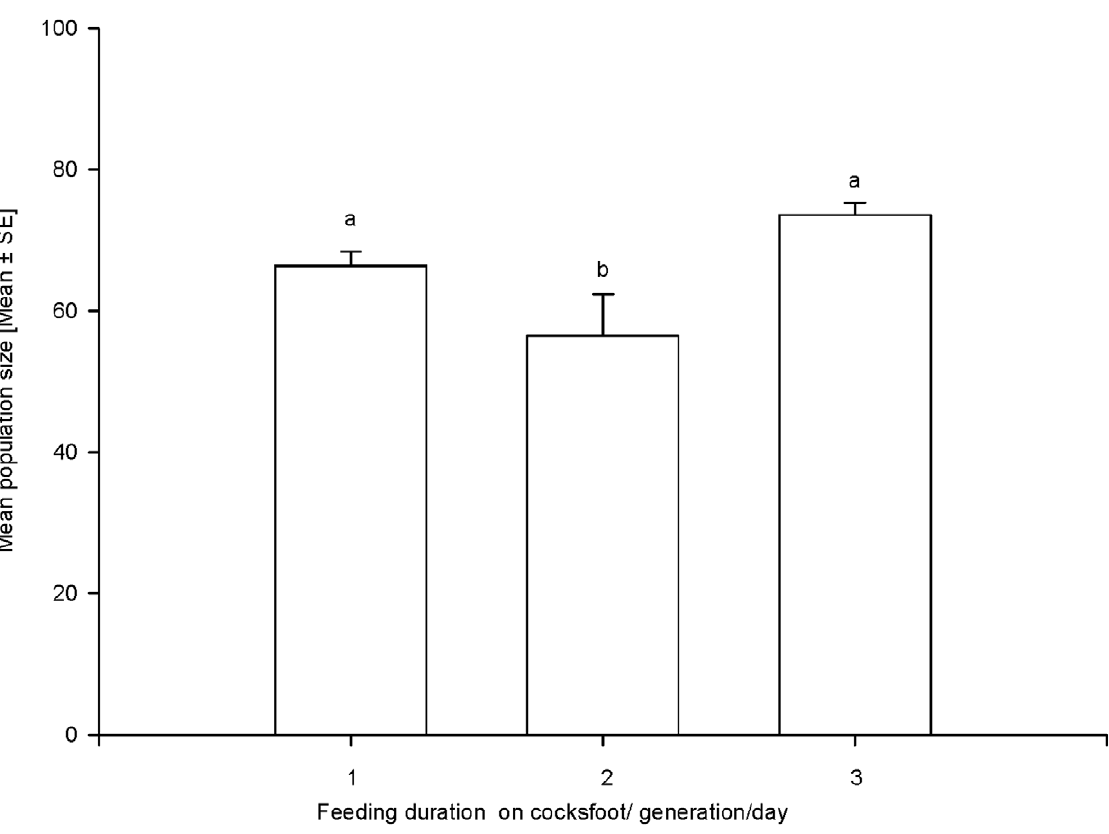
Figure 5. Effect of feeding duration on cocksfoot on the performance of S.avenae clone 5 on wheat; aphids fed many times with varying duration in different generations (F 2,27 =27.81, P , 0.001; R 2 =0.67). doi:10.1371/journal.pone.0054327.g005 experiment was done with five replications using the standard rearing conditions described above. Population size was monitored weekly. The surviving specimens on cultivar Prairial were reared